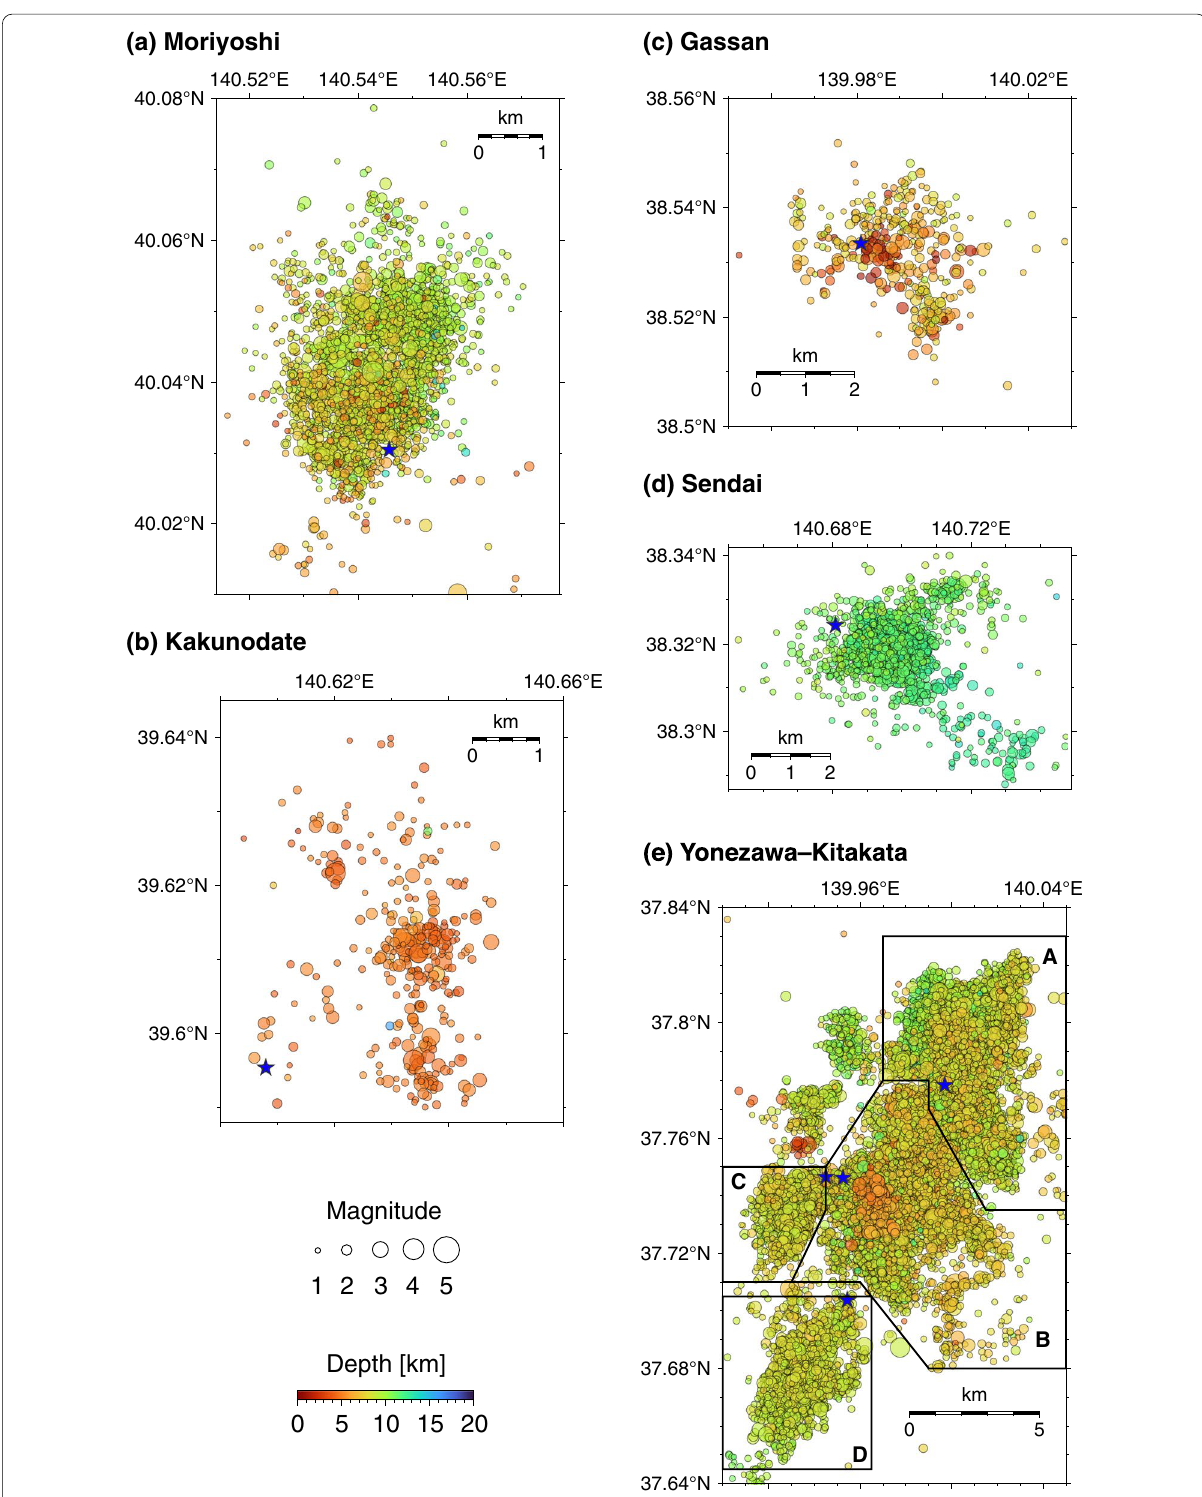
Fig. 2 Hypocenter distribution in each swarm area shown in Fig. 1. Colored circles denote the epicentral location of M occurred from 11 March 2011 to 31 December 2019 from the unified catalog of the Japan Meteorological Agency. The color and the size of circles indicate the depth and the magnitude of each event. a – e Show the seismicity for Moriyoshi, Kakunodate, Gassan, Sendai, and Yonezawa–Kitakata areas, respectively. A–D in e represents the subdivision of seismic clusters. Blue stars represent the epicenter of the first earthquake in each